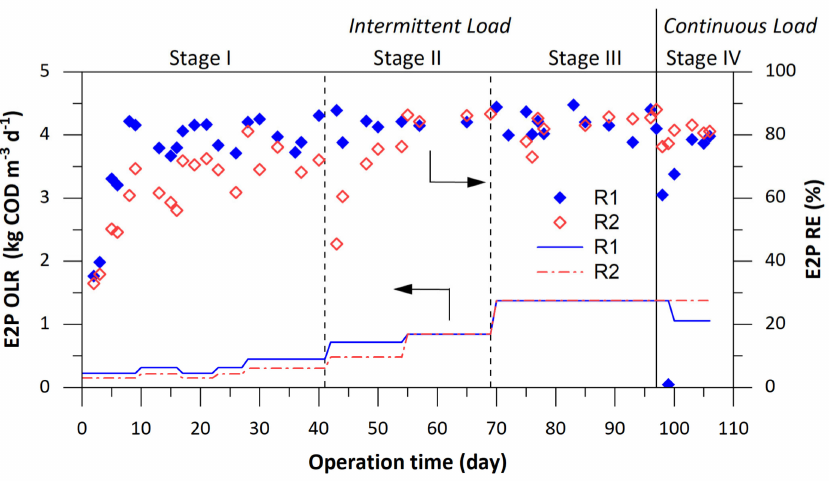
Figure 3. E2P organic load (—) and E2P removal efficiency ( (cid:7) , ♦ ). R1 operated at U L ≤ 0.15 m h − 1 and R2 operated at U L = 3.0 m h − 1 .